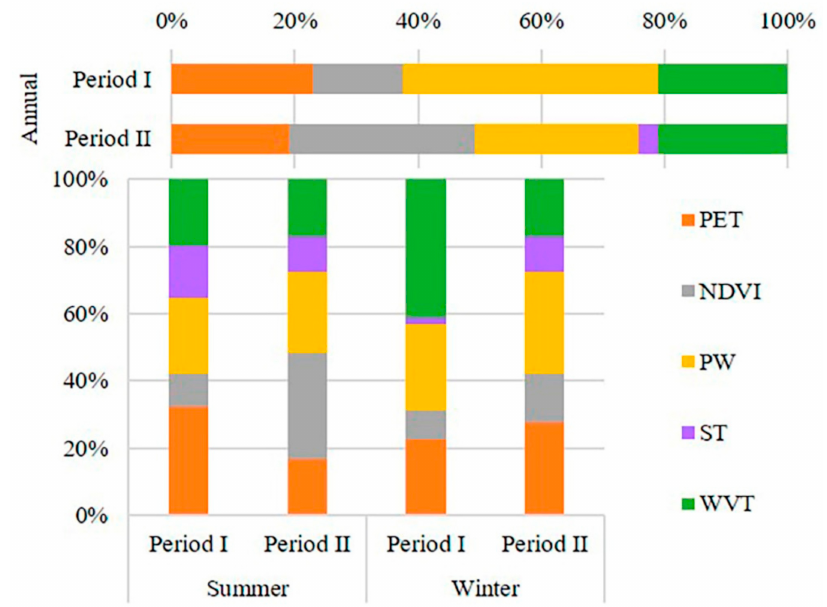
Figure 9. The influence degree of factors to precipitation before and after